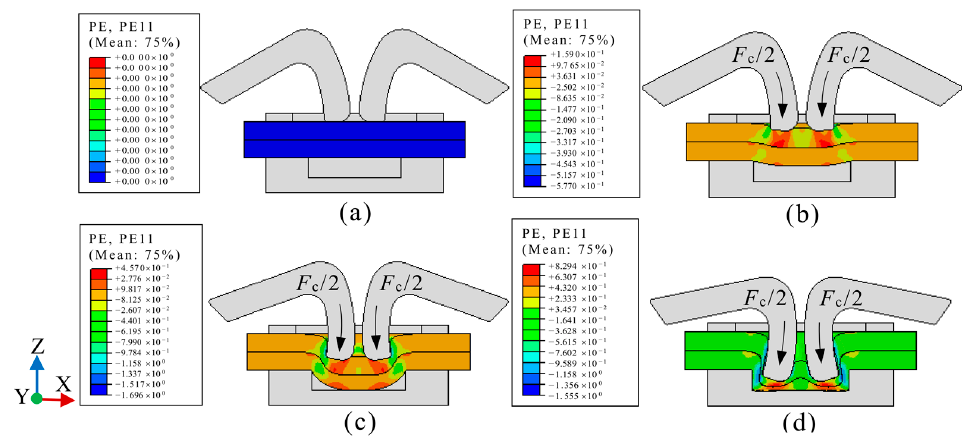
Figure 4. Strain distribution on the middle section of XZ during the rotated clinching process at four stages: ( a ) location, ( b ) drawing, ( c ) filling and ( d ) forming.